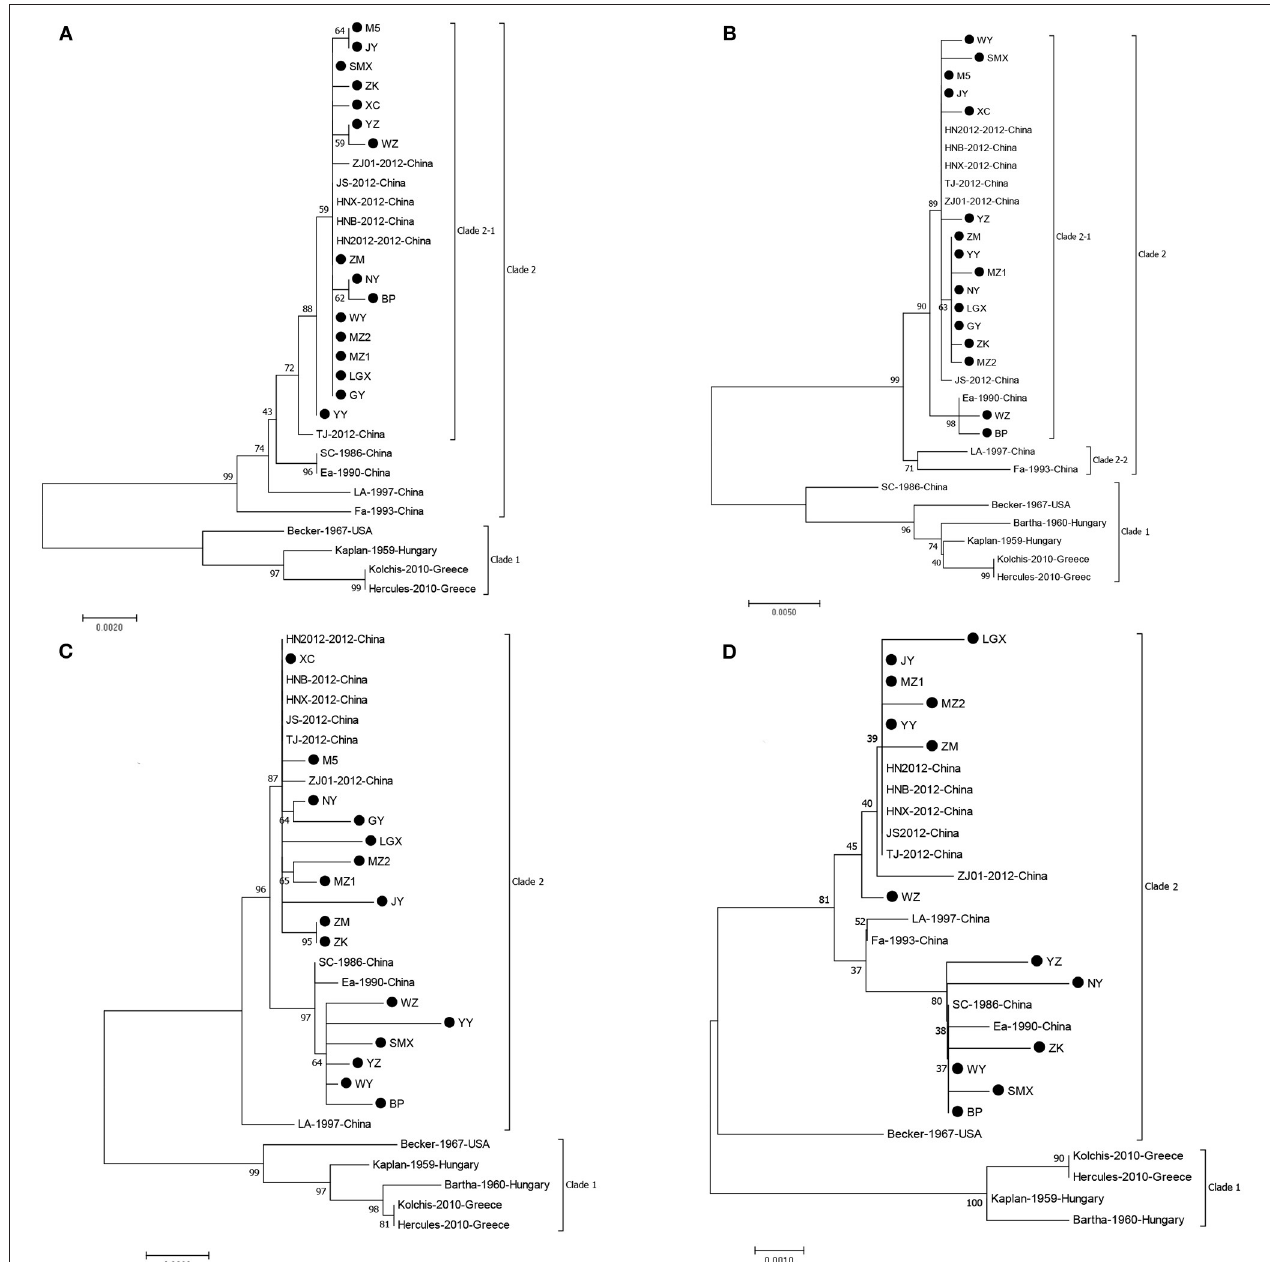
FIGURE 2 | Phylogenetic tree constructed by aligning nucleotide sequences of gE (A) , gC (B) , gB (C) , and gD (D) genes of the PRV isolates and reference strains using the NJ method. Bootstrapping with 1,000 replicates was performed to determine the percentage reliability for each internal node. Black circles indicate PRV field isolates in this